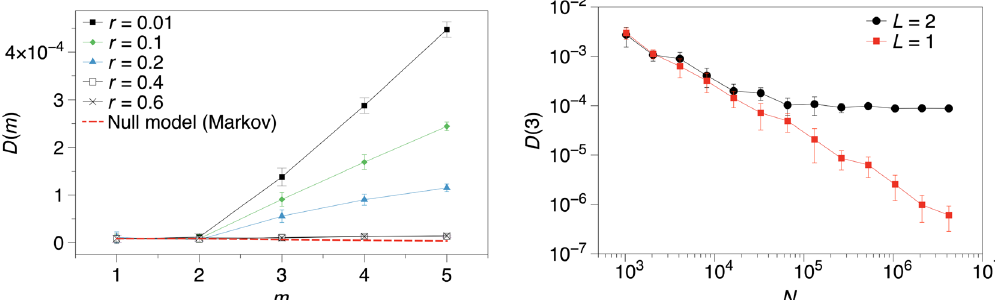
FIG. 2. (Left panel) Multiplexity detection statistic D ð m Þ [see Eq. (1)] for X ð t Þ , in a case where X ð t Þ shows an induced current, for different values of the switching rate r . The series X ð t Þ records the position of a walker diffusing over two layers, with transition 1 Þ 1 = 3 and T ð 2 Þ 1 = 2 , respectively, such that the transition probability in the Markovian probabilities in the layers given by T ð α ; α þ 1 ¼ α ; α þ 1 ¼ 5 = 12 . We correctly find that X ð t Þ is non-Markovian even for large values of r as D ð m Þj > 0 , which surrogate series is Q α ; α þ 1 ¼ m ≥ 3 suggests an underlying multiplex structure. (Right panel) Finite-size-scaling analysis where we compute D ð 3 Þ as a function of the series size N , for the multiplex considered in the left panel ( r ¼ 0 . 1 , green dots) and a null model with equivalent monoplex dynamics (red squares) for which D ð 3 Þ should vanish for large values of N . In both panels, the symbols represent the mean, and the error bars represent the standard deviation calculated over 10 different